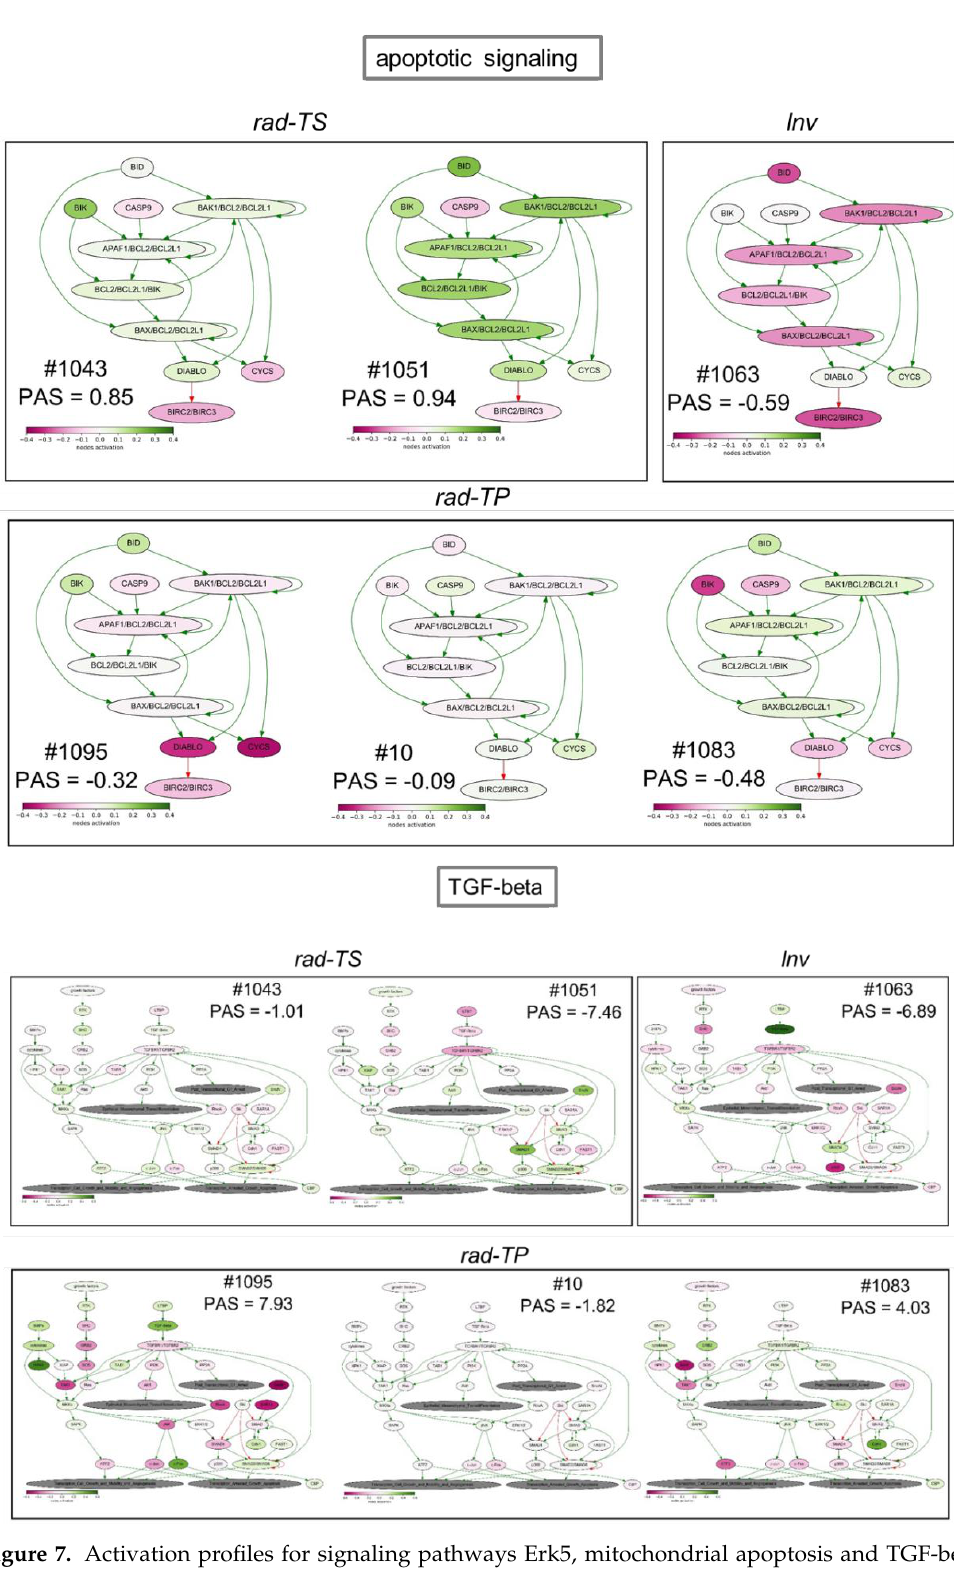
Figure 7. Activation profiles for signaling pathways Erk5, mitochondrial apoptosis and TGF-beta that were changed significantly in all GSCs / GSC_IR pairs tested. Numbers correspond to pathway activation scores (PAS) determined for individual pairs.